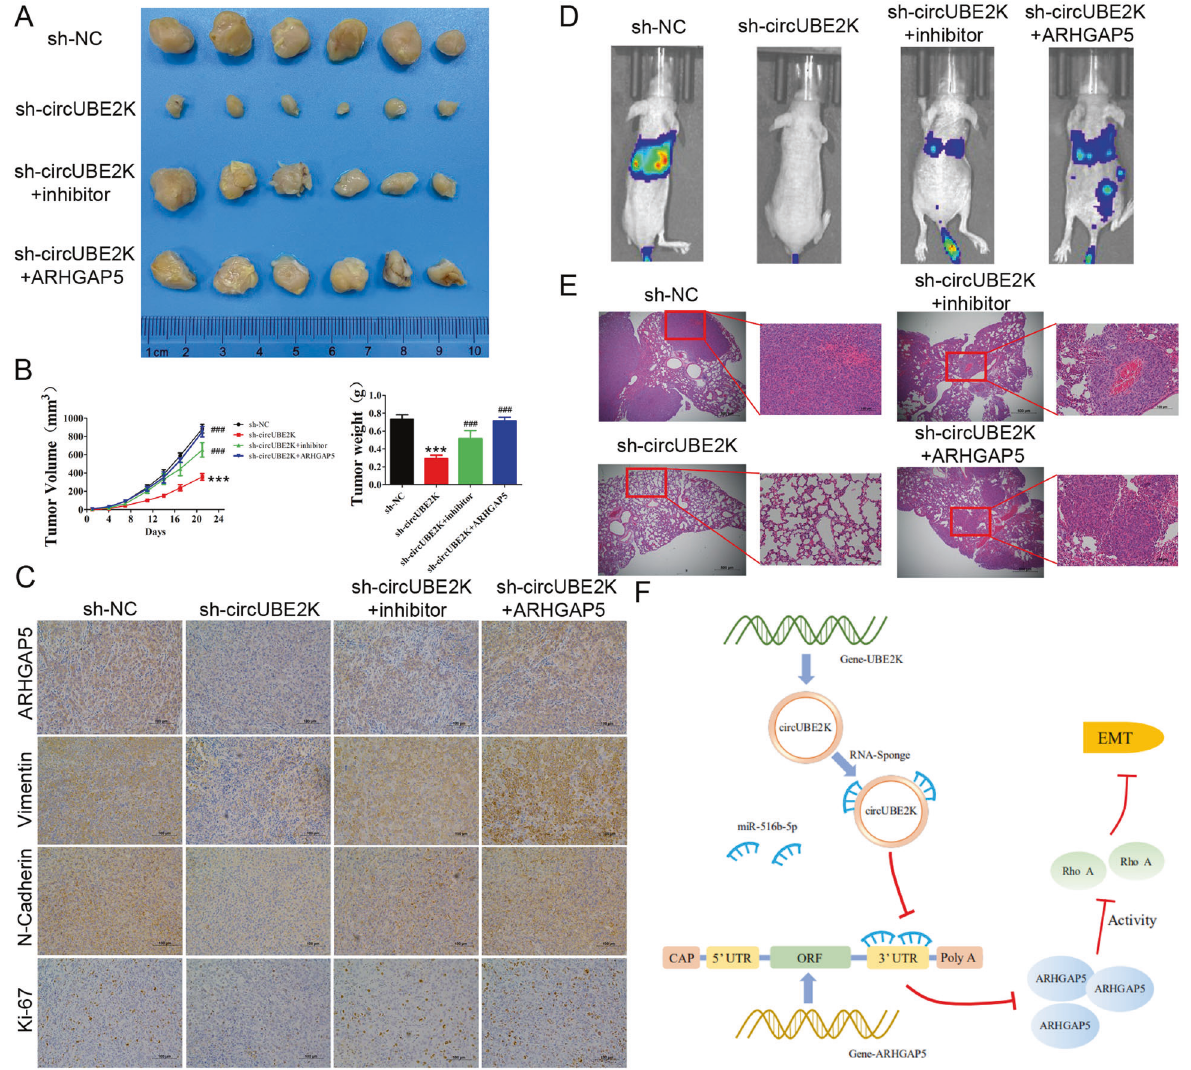
Fig. 8 Silencing circUBE2K suppressed BC growth in vivo. A Tumor sizes of T24-sh-NC and T24-sh-circUBE2K were shown in the fi gure. B Tumor growth of subcutaneous T24 tumors transfected with sh-NC (closed circles) or sh-circUBE2K (closed square) 21 days after tumor implantation. Average weights of tumors from sh-NC group and sh-circUBE2K group were shown in the histogram. Error bars indicate SD. C Expression levels of ARHGAP5, Vimentin, N-Cadherin, and Ki-67 were measured by immunohistochemical staining. Representative views of slides from sh-NC group (Left panel) and sh-circUBE2K (Right panel) were shown. D Bioluminescence imaging in mice metastasis model (Left, NC-T24) and circUBE2K knockdown T24 cells (Right, si-circUBE2K-T24). Imaging revealed that silencing circUBE2K reduced metastasis potential of T24 cells. E Representative hematoxylin and eosin-stained sections of lung tissues from NC-T24 (Top) and si-circUBE2K-T24 (Bottom) bearing mice. F System role of circUBE2K in the oncogenesis scheme of bladder